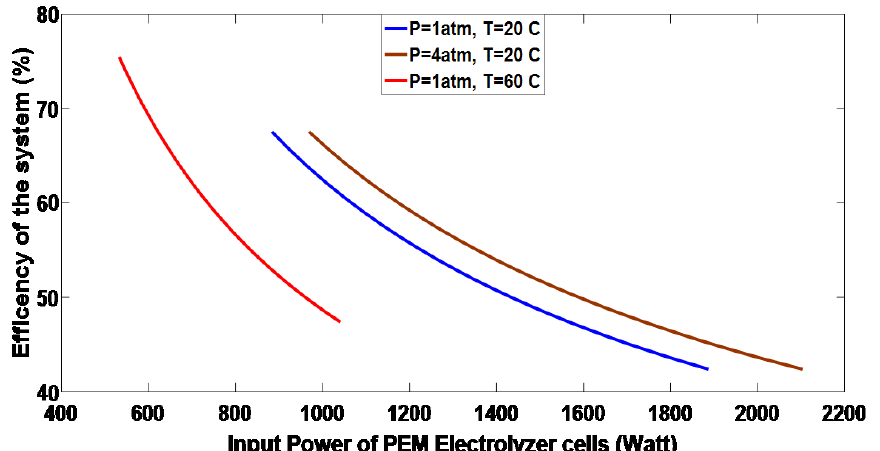
Figure 25. Efficiency of PEM electrolysis vs. the input electrical power of PEM electrolysis at different operating conditions.